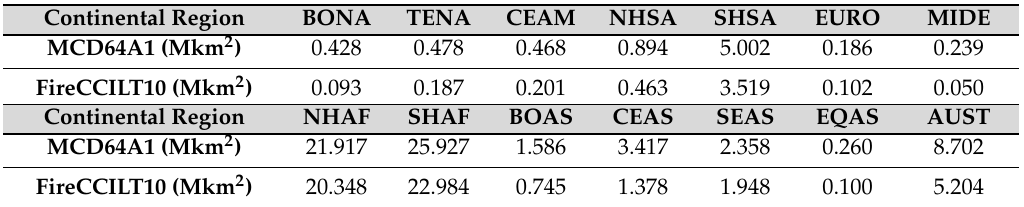
Table 2. Average Burned Area of the FireCCILT10 and MCD64A1 products (2001–2017) in the continental regions. Boreal North America (BONA), Temperate North America (TENA), Central America (CEAM), Northern Hemisphere South America (NHSA), Southern Hemisphere South America (SHSA), Europe (EURO), Middle East (MIDE), Northern Hemisphere Africa (NHAF), Southern Hemisphere Africa (SHAF), Boreal Asia (BOAS), Central Asia (CEAS), Southeast Asia (SEAS), Equatorial Asia (EQAS) and Australia and New Zealand